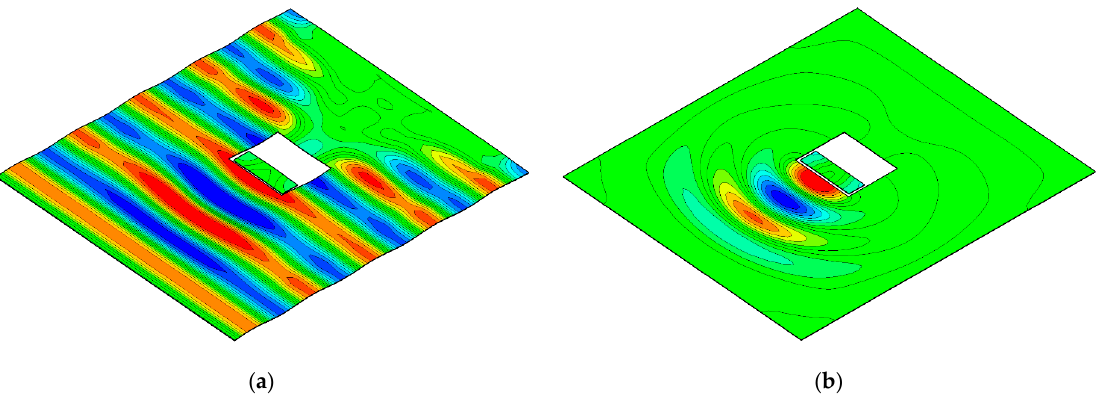
Figure 6. Wave fields around the OWC chamber in the three-dimensional numerical wave tank: ( a ) wave excitation simulation; ( b ) forced radiation simulation.